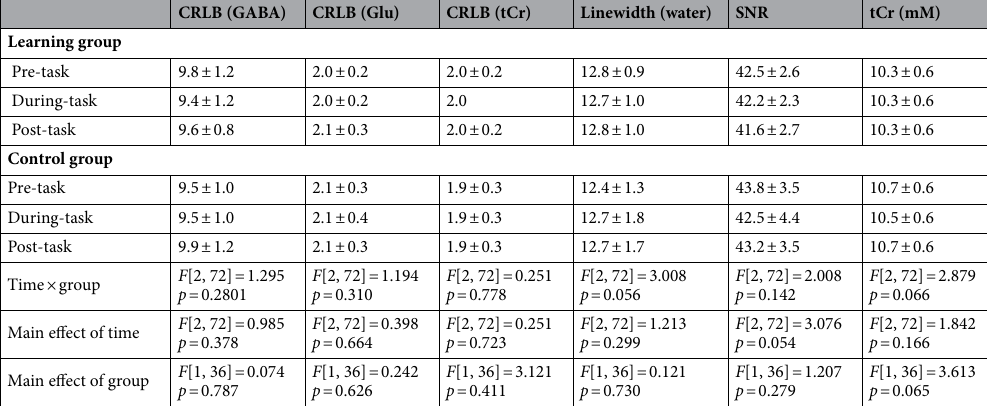
Figure 2A represents an example of MR spectra within the M1 obtained using the 7T MR sys- tem. To assess whether the changes in metabolite concentrations were due to fluctuations in spectral quality, we evaluated the Cramer–Rao lower bounds (CRLB), linewidth, and signal-to-noise ratio (SNR). MRS spectra pro- vided reliable estimates of GABA, Glu, and total creatine (tCr), with a CRLB < 15%. Two-way repeated-measures analysis of variance (ANOVA) revealed no significant main effect of time (pre-task vs. during-task vs. post-task) or group (learning vs. movement) on CRLB, linewidth, or SNR (Table 1). Figure 2B presents the distribution of the concentrations of GABA/tCr and Glu/tCr in the pre-, during-, and post-task periods and the relationship between GABA and Glu changes. The variation in neurotransmitter concentration was analyzed using repeated-measures ANOVA with time (pre-task vs. during-task vs. post-task) and group (learning vs. control) as factors. No significant main effect of time ( F (2,72) = 0.144; p = 0.856) or group